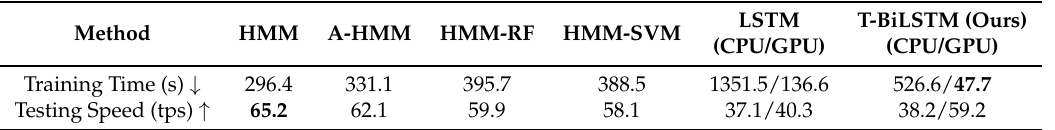
Table 8. The training time (in seconds, lower is better) and the testing speed (trajectory per second) of these methods. The best values are highlighted using a bold